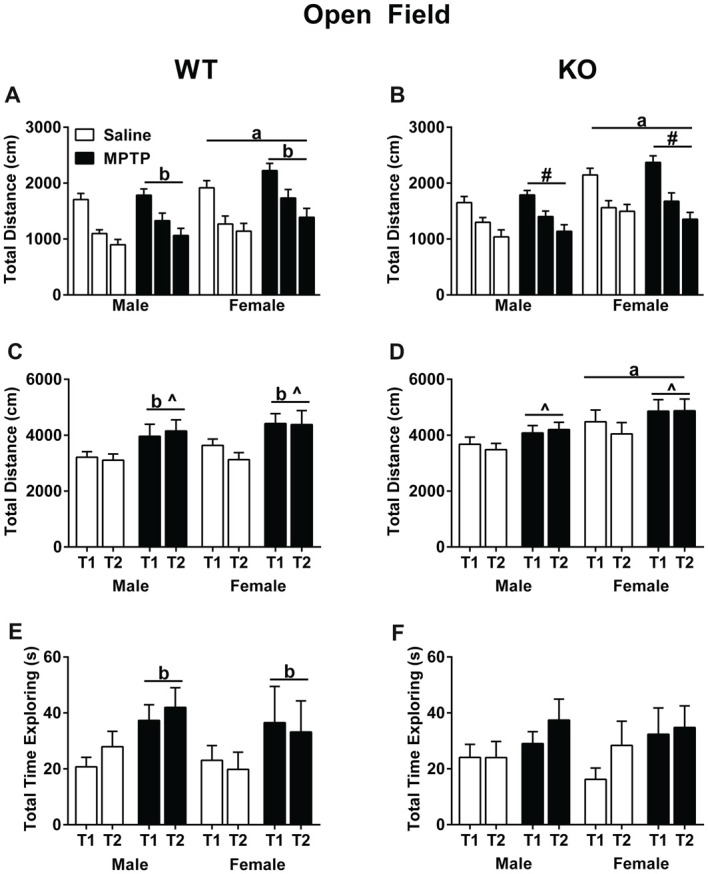
Activity of saline- and MPTP-treated WT and KO mice in the open field (A,B), in the open field containing two objects over two subsequent days (C,D), and total time spent exploring the objects (E,F). (A,B) All groups habituated to open field; effect of day; WT: p < 0.001; KO: p < 0.001. WT mice treated with MPTP traveled more distance than saline-treated WT mice. bp = 0.043. WT and KO females moved more than genotype-matched males in the open field. WT: ap = 0.001; KO: ap < 0.001. (C,D) WT MPTP-treated mice moved more than saline mice in the open field containing two objects (p = 0.004). WT and KO saline-treated mice moved less on the second day than the first day in the open field containing two objects. WT: ^p = 0.024; KO: ^p = 0.04. KO females moved more overall than KO males. ap = 0.038). (E,F) In WT mice, MPTP increased the time the mice spent exploring the objects. bp = 0.034. # refers to an interaction between sex and day (F(2,84) = 3.880; p = 0.024).